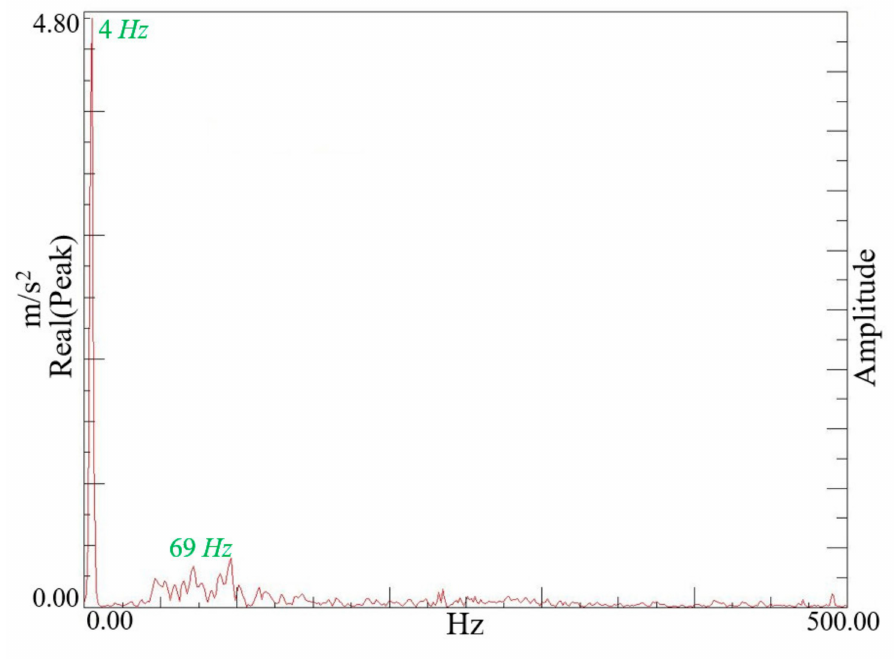
Figure 19. Vertical acceleration frequency-domain curve of the swing